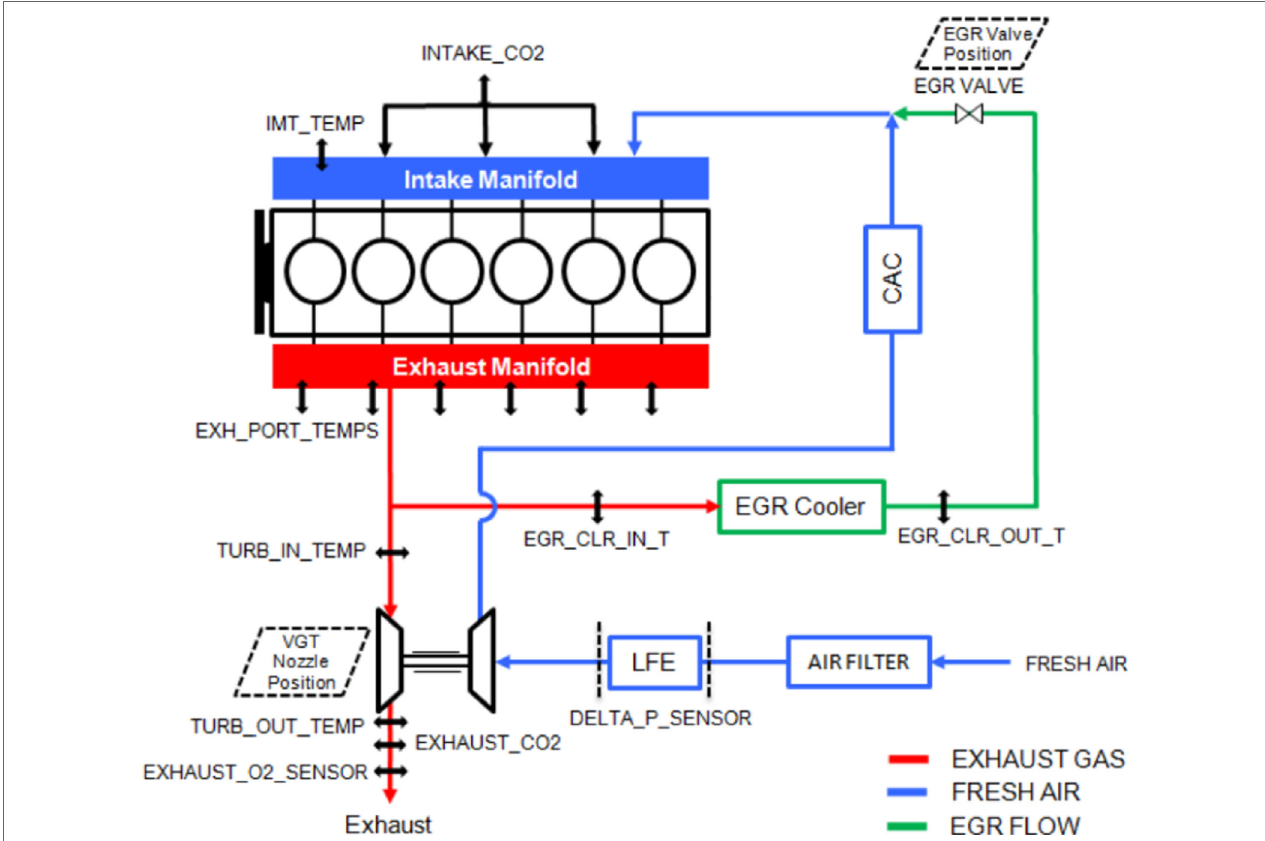
FigUre 1 | Schematic of the air handling system of the engine indicating the positions of relevant actuators and sensors.